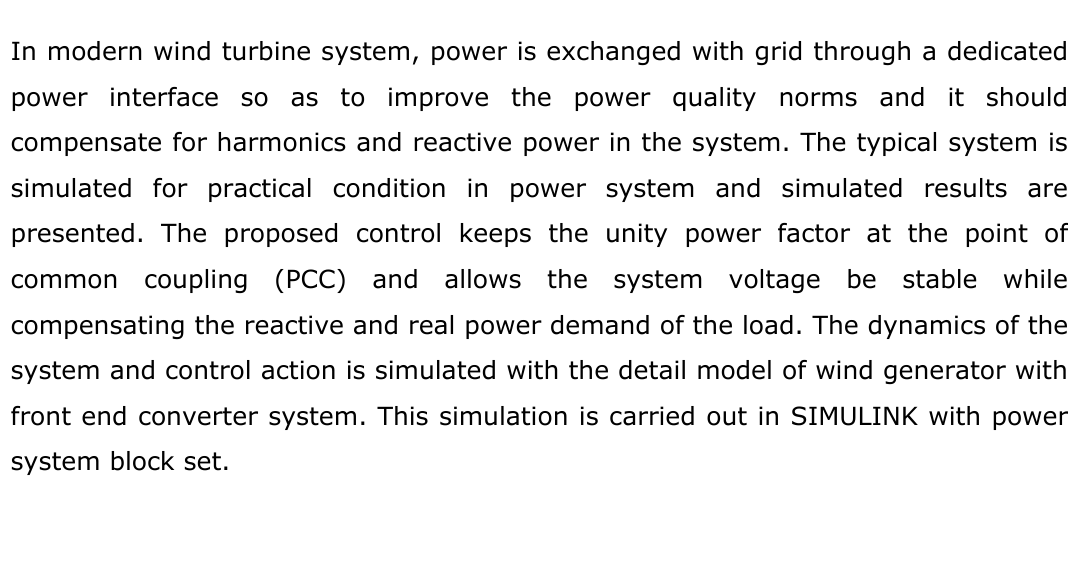
Figure 1. “Wind –Generation system Interconnection with power